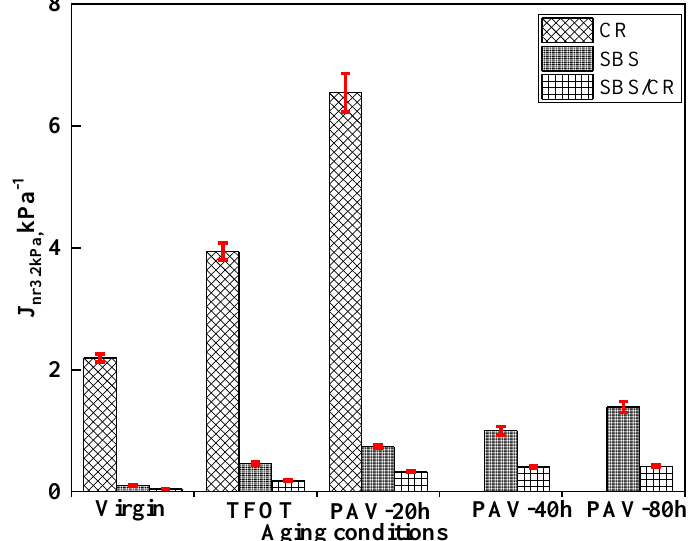
Figure 1. J nr3.2 value for three kinds of modified bitumen at different aging conditions.